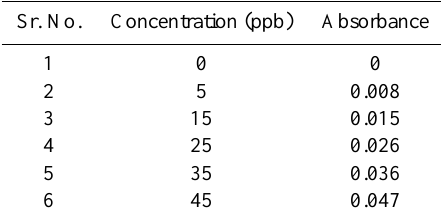
Figure-6: Absorbance Vs. Concentration without Straight Line